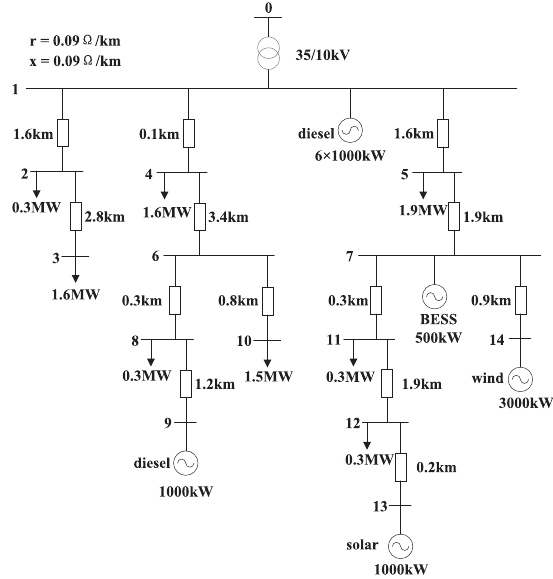
Figure 1. The distribution network configuration we consider [1] for a certain realization of load Fig. 3. Topology of the microgrid [6]. and supply.